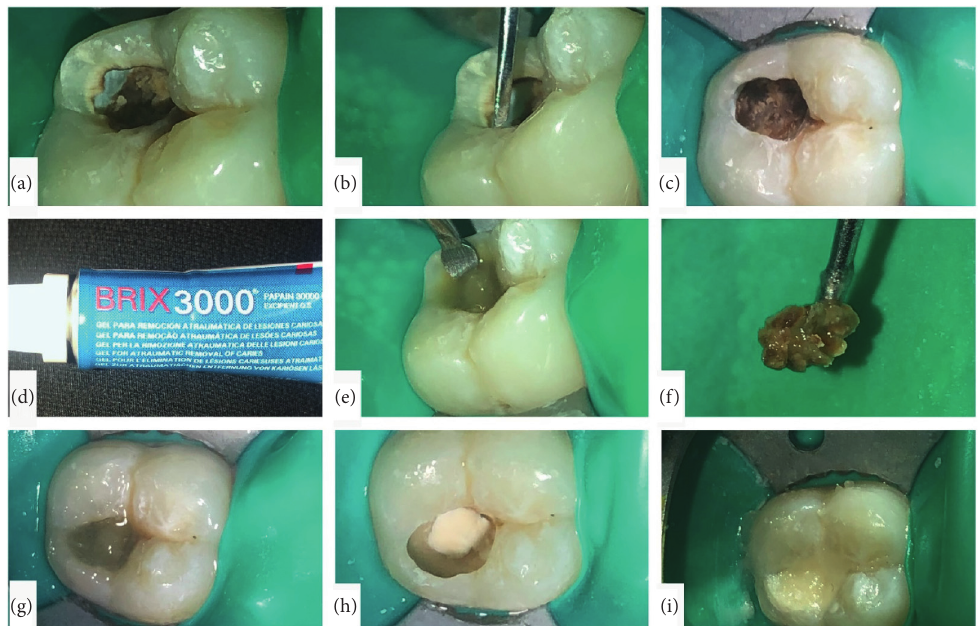
Figure 1: Stepwise procedure of performing pulp capping: Step a, isolation of the affected tooth using dental dam. Step b, removal of the friable margins. Step c, after removal of the friable margin and preparing the cavity for using ARTmaterial. Step d, papain gel as a material for performing ART. Step e, application of the papain gel. Step f, excavated carious portion. Step g, reapplication of the papain gel. Step h, pulp capping with MTA base. Step I, restoration of the cavity using capsulated GIC